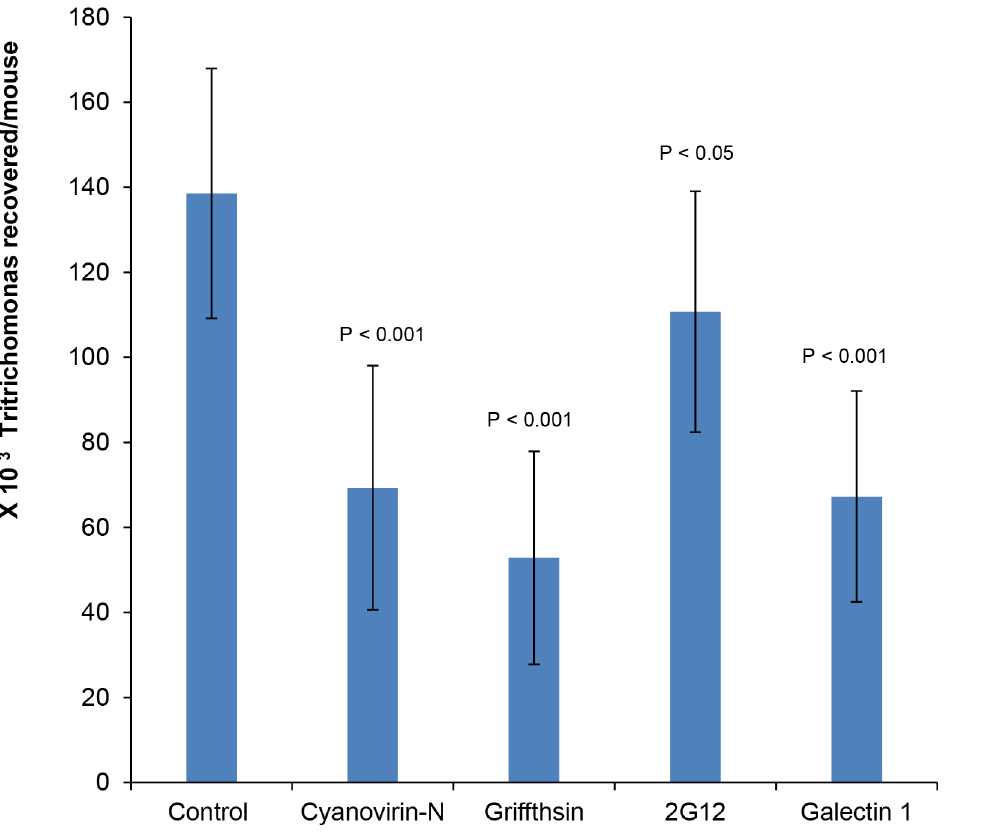
Fig 5. Anti-retroviral lectins decrease recovery of Tritrichomonas in a mouse vaginal model. Recovery of Tritrichomonas after two days in the vagina of mice shows a modest but statistically significant decrease by co-infection with cyanovirin-N (63% decrease), griffithsin (70% decrease), or galectin-1 (51% decrease). In contrast, there is little effect of the 2G12 monoclonal antibody. Data is the average of three experiments each containing five mice per treatment.